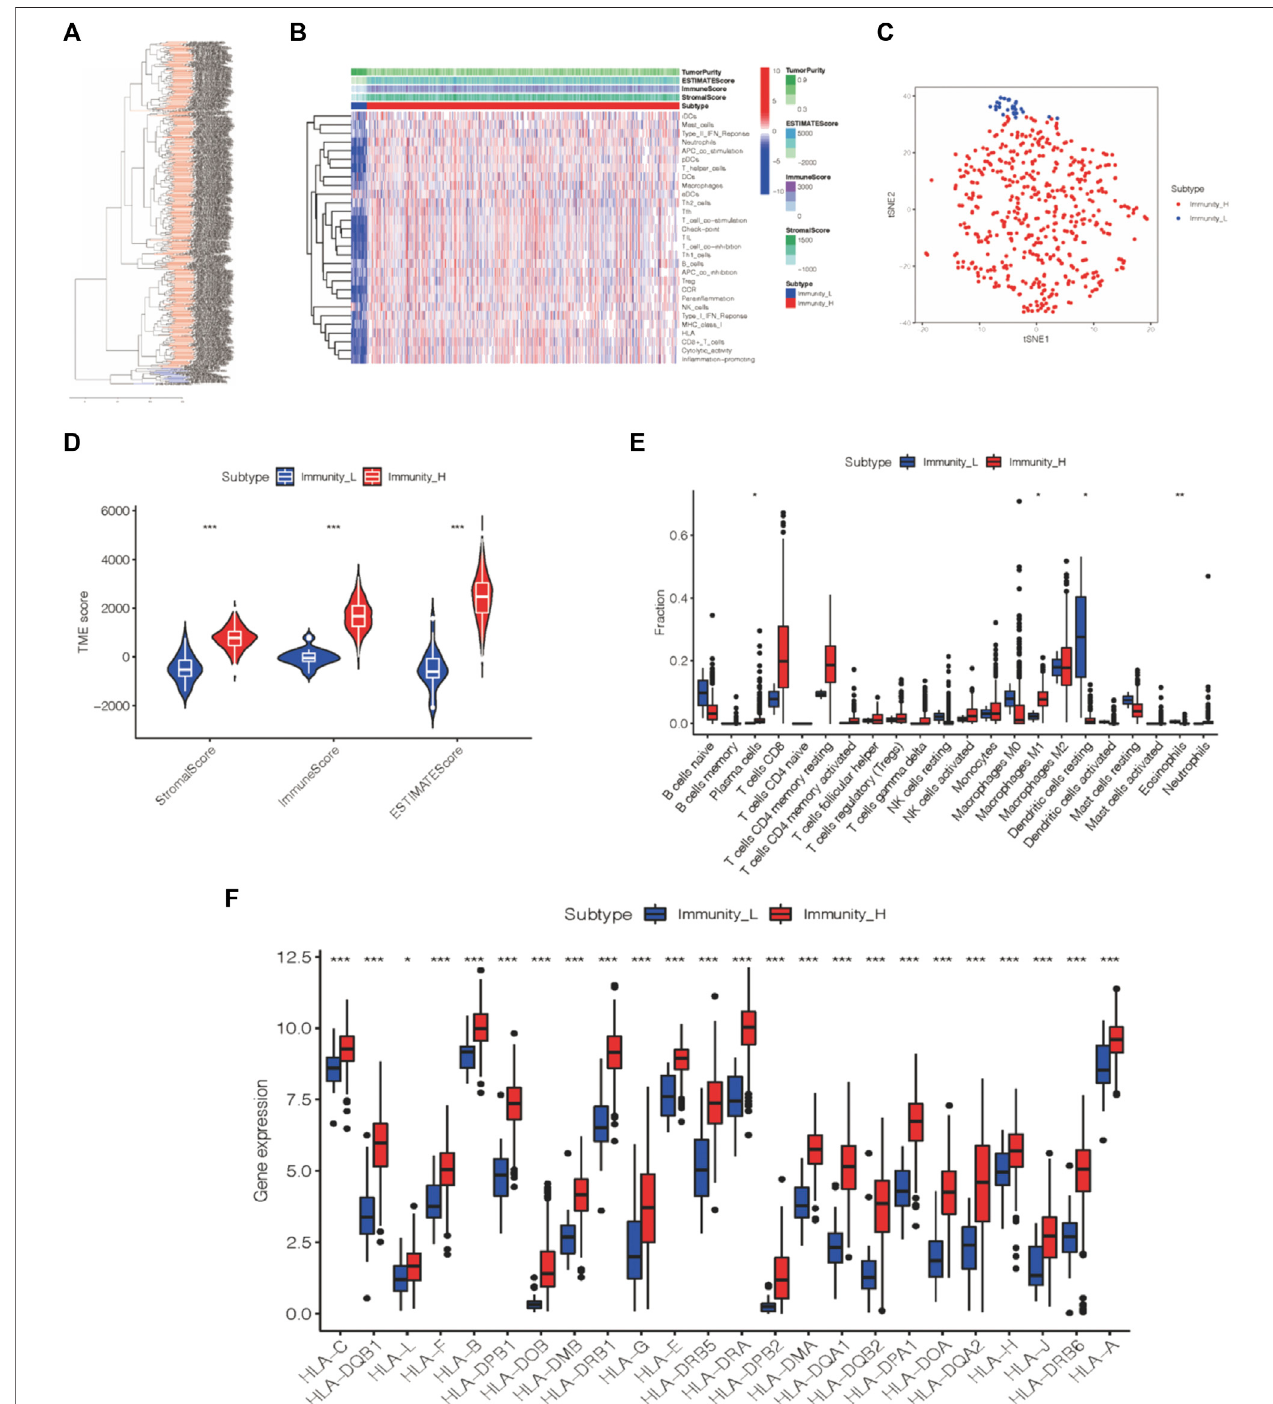
FIGURE 1 | Two immune subtypes of ccRCC were established via hierarchical clustering. (A) ssGSEA results were used to generated two distinct groups via hierarchical clustering. (B) Tumor microenvironment characteristics were generated in the TCGA-KIRC cohort. (C) Immunophenotype validation via tSNE. (D) Three different immune scores of each group. (E) Immune cell in fi ltration degree of two immunogenic subtypes. (F) HLA-associated gene level of each of the two groups. * p < 0.05, ** p < 0.01, *** p < 0.001.